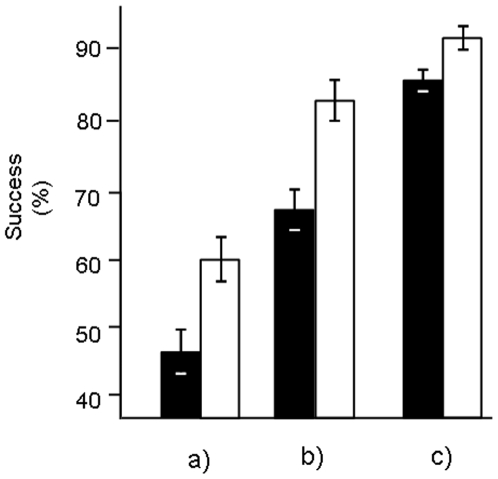
Effect of polyandry on a) fertilisation success; b) hatching success and c) larval survival in Galeolaria caespitosa.Solid bars and open bars show mean (±S.E.) for the single-males treatment and multiple-males treatment respectively.